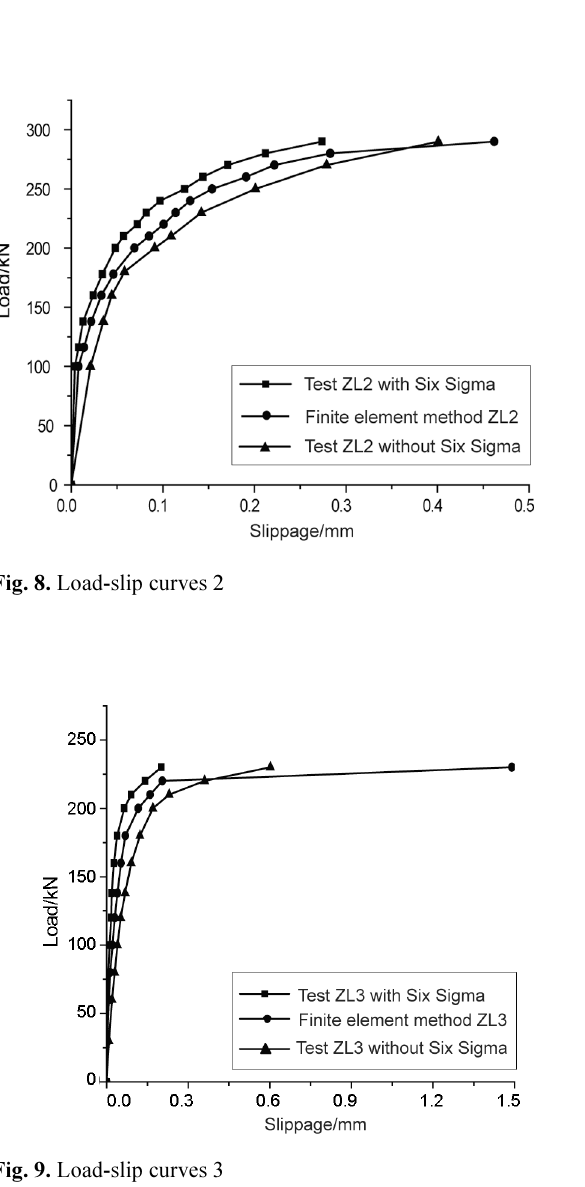
Fig. 7. Load-slip curves 1